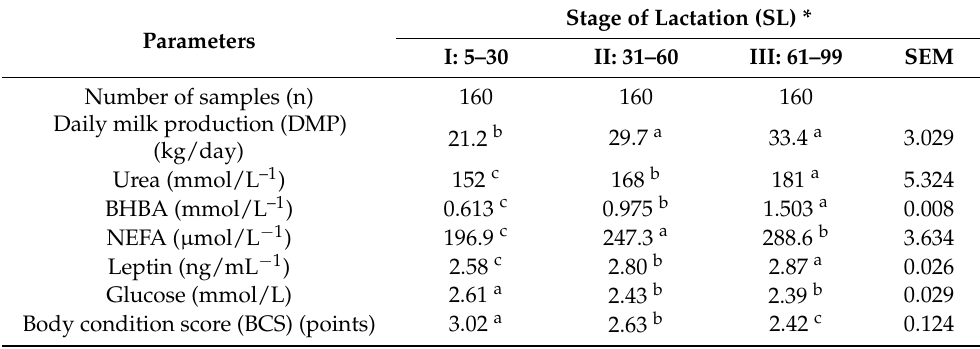
Table 4. Milk yield and parameters of energy metabolism in cows up to 100 days of lactation.